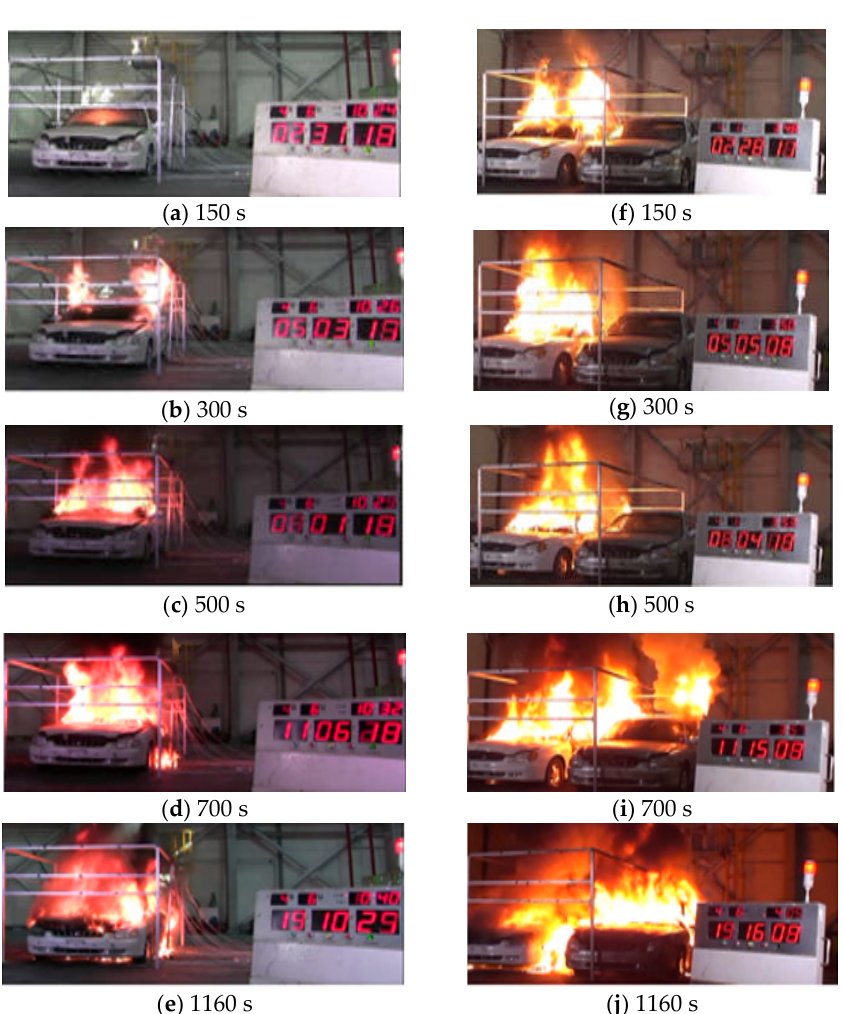
Figure 5. Fire spreading as a function of time for one and two vehicles; ( a ) 150 s after fires in one vehicle, ( b ) 300 s after fires in one vehicle, ( c ) 500 s after fires in one vehicle, ( d ) 700 s after fires in one vehicle, ( e ) 1160 s after fires in one vehicle, ( f ) 150 s after fires in two vehicles, ( g ) 300 s after fires in two vehicles, ( h ) 500 s after fires in two vehicles, ( i ) 700 s after fires in two vehicles, and ( j ) 1160 s after fires in two vehicles.